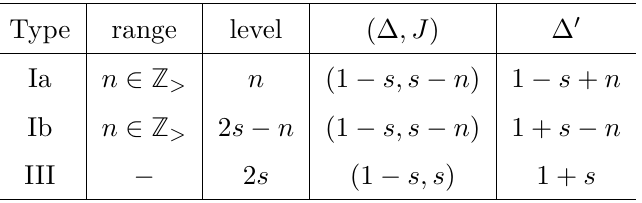
Table 11. Spectrum of primaries that can descend to radiative primary descendants with | J 0 | = s . We can only have non-zero wavefunctions if | J | ≤ s , which excludes the type II case. We see that the only parents which descend to radiative primaries have ∆ = 1 − s